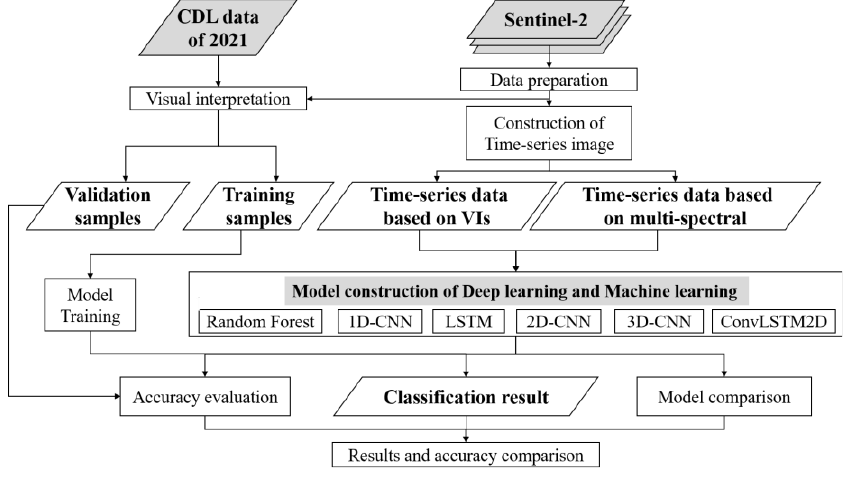
Figure 2. General workflow of this